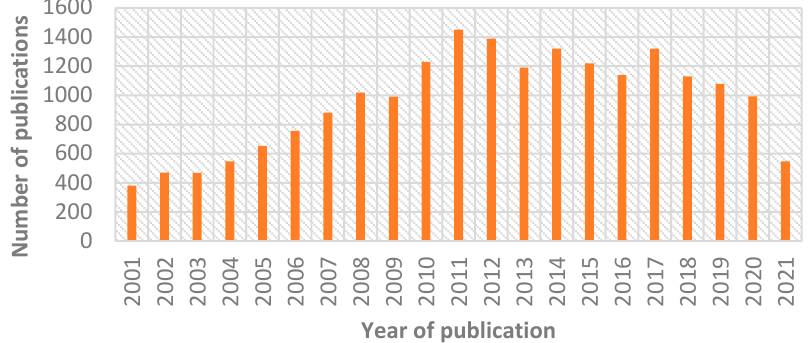
Figure 1. The number of publications with “heat pump” in the title.